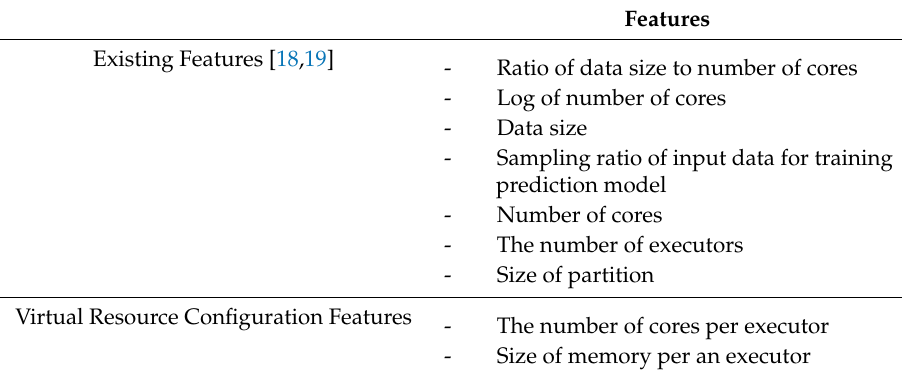
Table 1. Features of the existing models and our model.